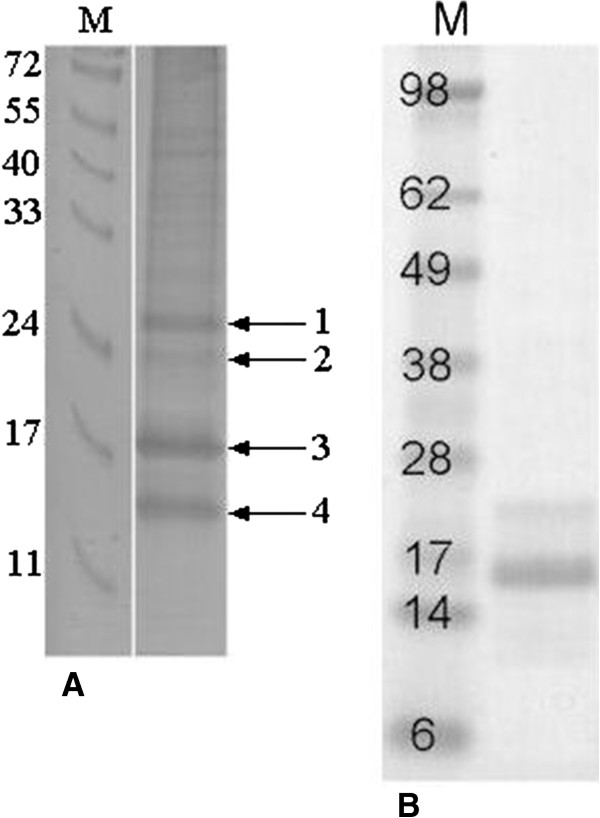
Coomassie stained gels. A; natural hazelnut OAP fraction. Indicated are the bands identified by mass-spectrometry. (1) contained little amounts of both oleosins, but the main constituent remained unidentified, (2) 11S globulin (AAL73404, Cor a 9) and (3) and (4) mainly consisted of both oleosins, AY224679 (Cor a 12) being the most abundant. In addition, a protein with similarity to caleosins was detected in these bands. B; Purified recombinant oleosin Cor a 12. Marker sizes are indicated.